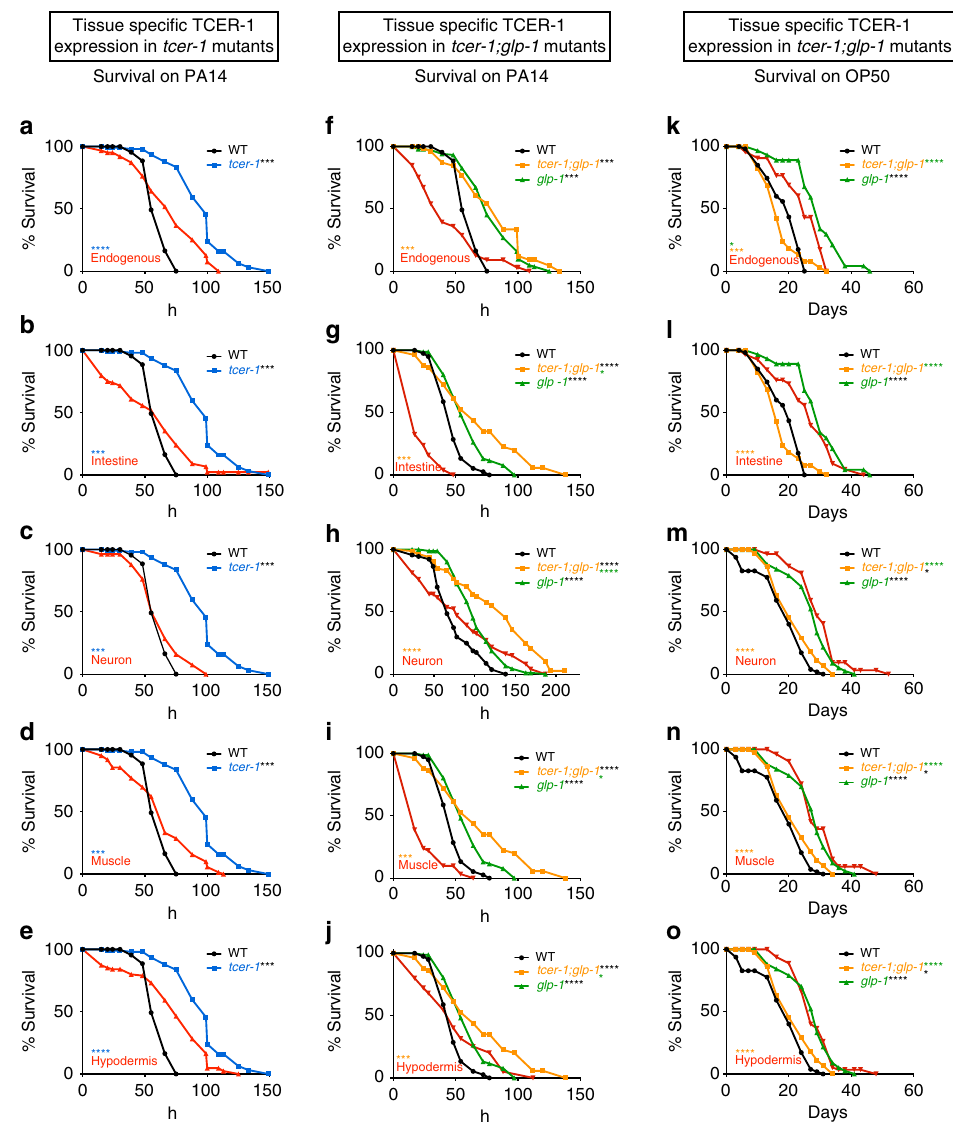
Fig. 2 TCER-1 acts cell non-autonomously to suppress immunity and promote longevity. a – j TCER-1 expression in any somatic tissue suppresses PA14 resistance. Mean survival (hours) of L4 larvae transferred to PA14. a – e Expression in tcer-1 mutants. Wild type (WT, black, 60.68), tcer-1 (blue, 96.31) and tcer-1 mutants expressing TCER-1 (red) under control of a endogenous promoter (70.91) or promoters expressed in b intestine ( gly-19 , 55.3), c neurons ( rgef-1 , 62.32), d muscles ( myo-3 , 64.0) or e hypodermis ( col-12 , 71.67). f – j Expression in tcer-1;glp-1 mutants. f Native expression. Wild type (WT, 60.68), glp-1 (79.2), tcer-1;glp-1 (orange, 80.3) and tcer-1;glp-1 mutants expressing TCER-1 under the control of endogenous promoter (44.0). g – j Tissue-speci fi c expression. WT (47.61), glp-1 (59.52), tcer-1;glp-1 (67.98) and tcer-1;glp-1 mutants expressing TCER-1 (red) under the control of promoters expressed in g intestine (22.45), i muscles (25.03) or j hypodermis (47.15). h Neurons: WT (75.3), glp-1 (102.34), tcer-1;glp-1 (126.59) and neuron-expressed TCER-1 (84.31). k – o TCER-1 expression in any somatic tissue extends tcer-1;glp-1 mutant ’ s lifespan on OP50. Mean survival (days) on OP50. k , l WT (18.7), glp-1 (29.32), tcer-1;glp-1 (17.11) and tcer-1;glp-1 mutants expressing TCER-1 under k endogenous promoter (24.14) and l tissue-speci fi c expression in